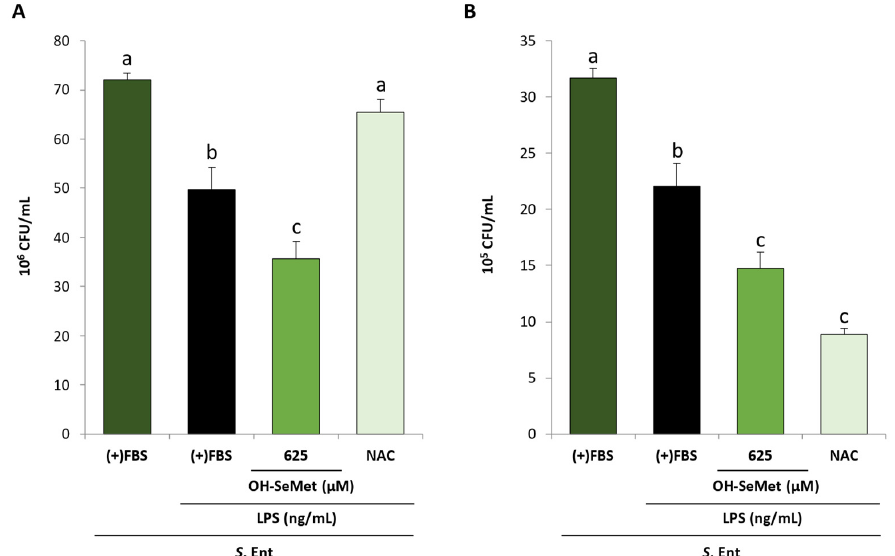
Figure 9. Extracellular ( A ) and intracellular ( B ) CFU counts in macrophages maintained in (+)FBS for 24 h, supplemented for 24 h with 625 µ M OH-SeMet or 10 mM NAC, stimulated with LPS (250 ng/mL) for 24 h, and then infected with Salmonella Enteritidis (MOI 10) for 3 h. The results are expressed as mean ± SEM of n = 6 cultures. Different letters denote significant differences ( p < 0.05) between conditions. CFU, colony-forming units; S. Ent, Salmonella Enteritidis.